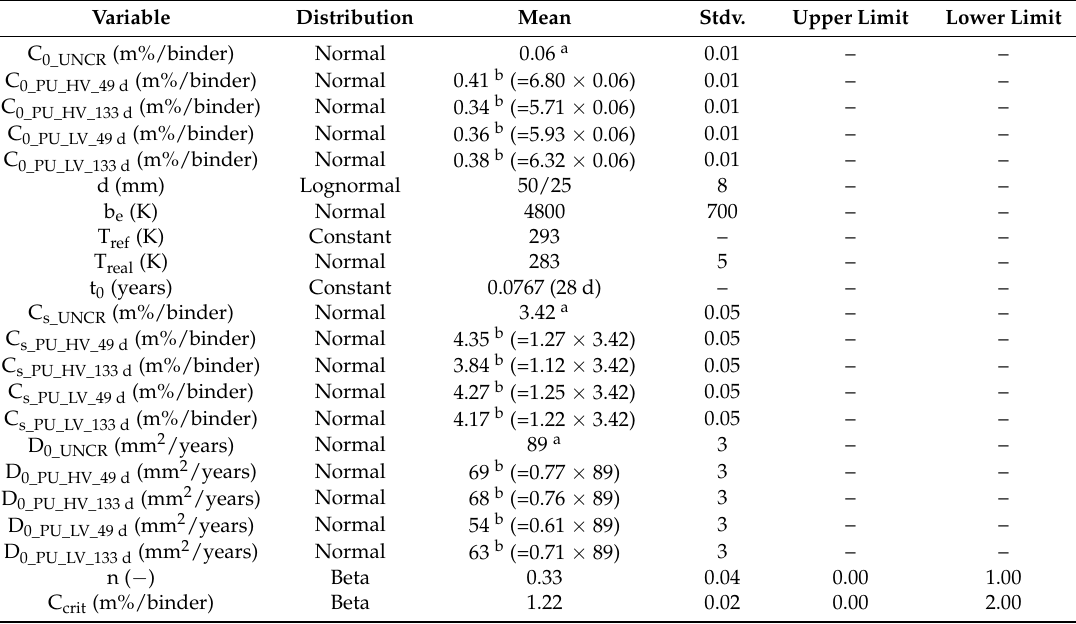
Table 3. Input to the probabilistic diffusion test based limit state function for estimating the time to chloride-induced steel depassivation for (un)cracked and healed